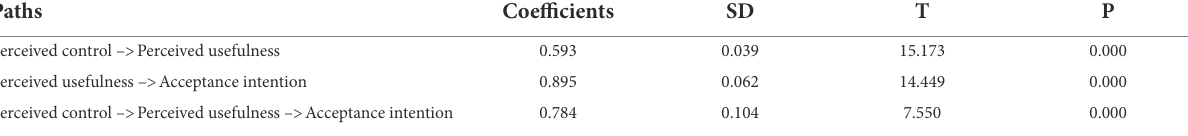
TABLE 4 Core path